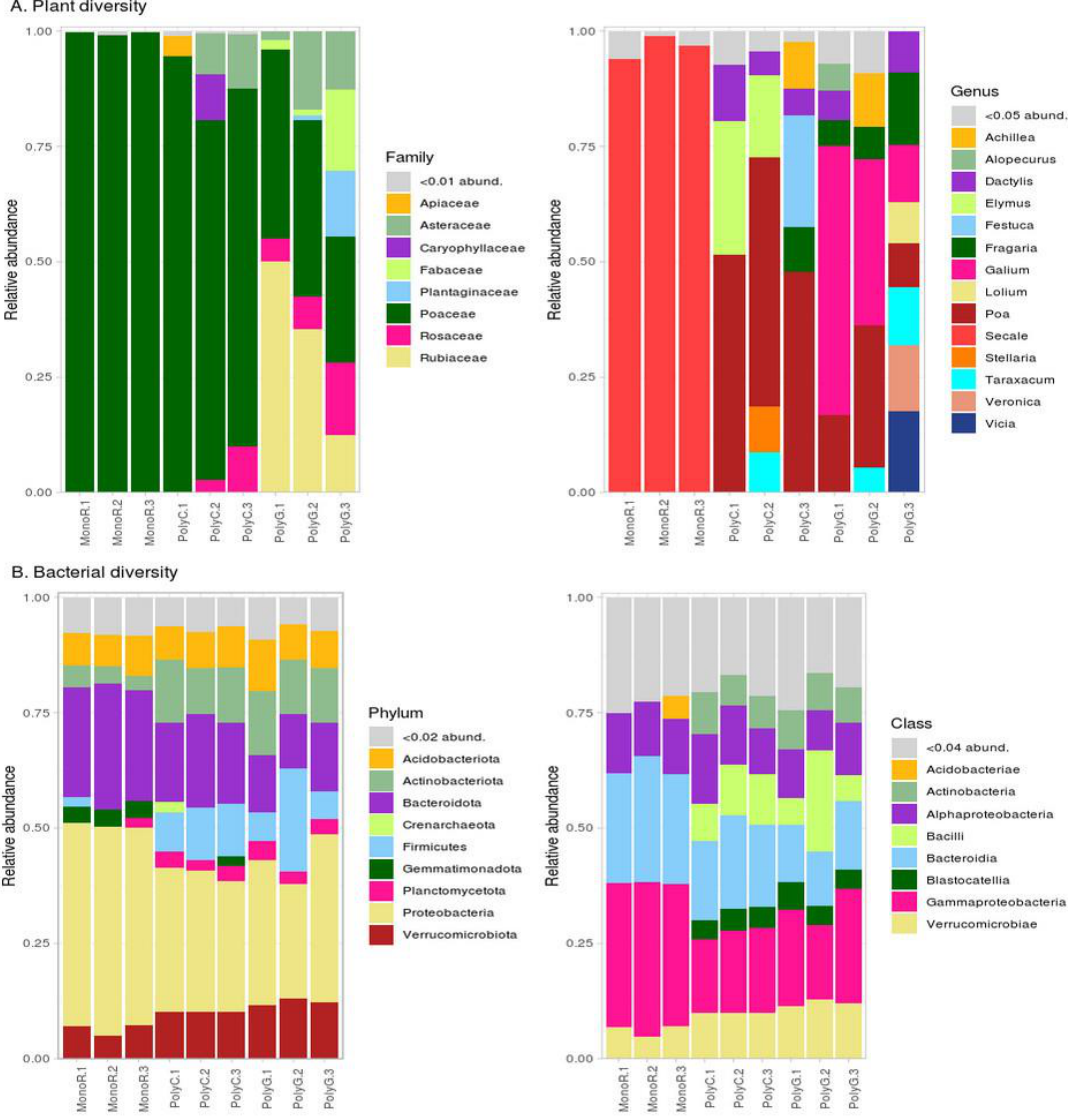
Figure 1. Relative abundances of plant and bacterial communities in the experimental sites. ( A ): Plant diversity; ( B ): Bacterial diversity.